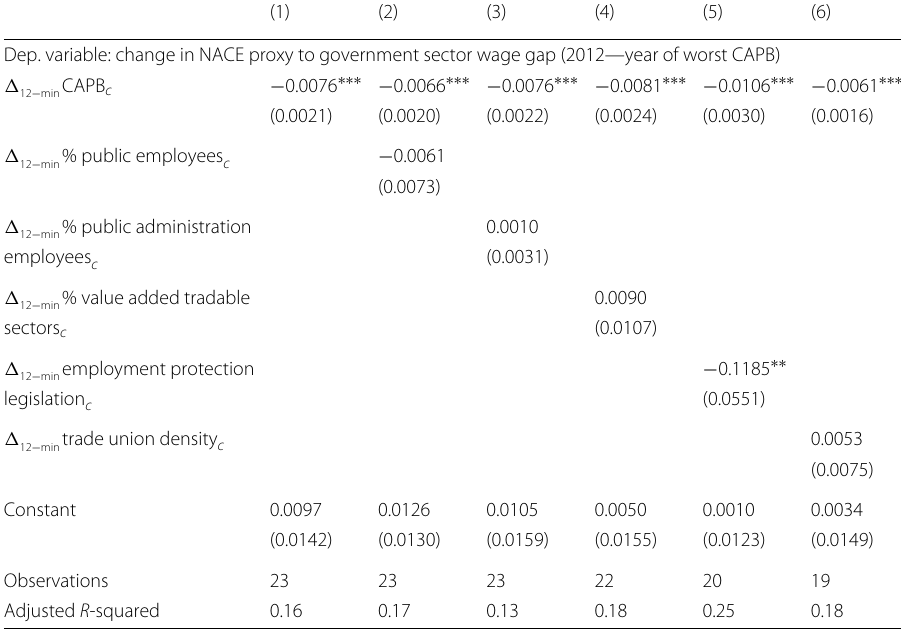
Table 4 The public pay gap during the crisis: determinants of change between 2007 and 2012 (1) (2) (3) (4) (5)